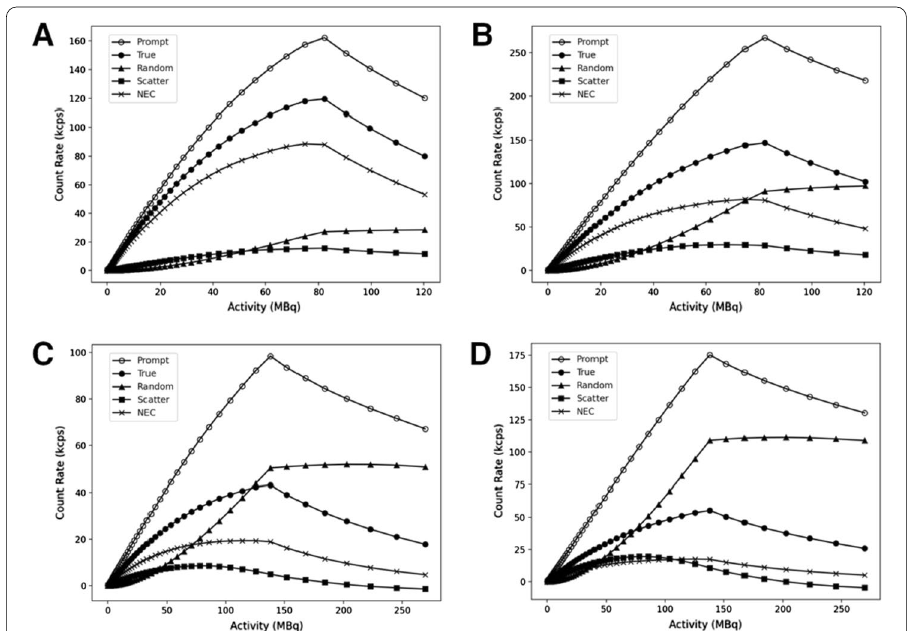
Fig. 3 System total, true, random, and scattered event rates, and system NEC as function of the activity for the rat‑like (A and B) and the monkey‑like (C and D) phantoms considering the 400–620 keV and 250–750 keV energy windows,